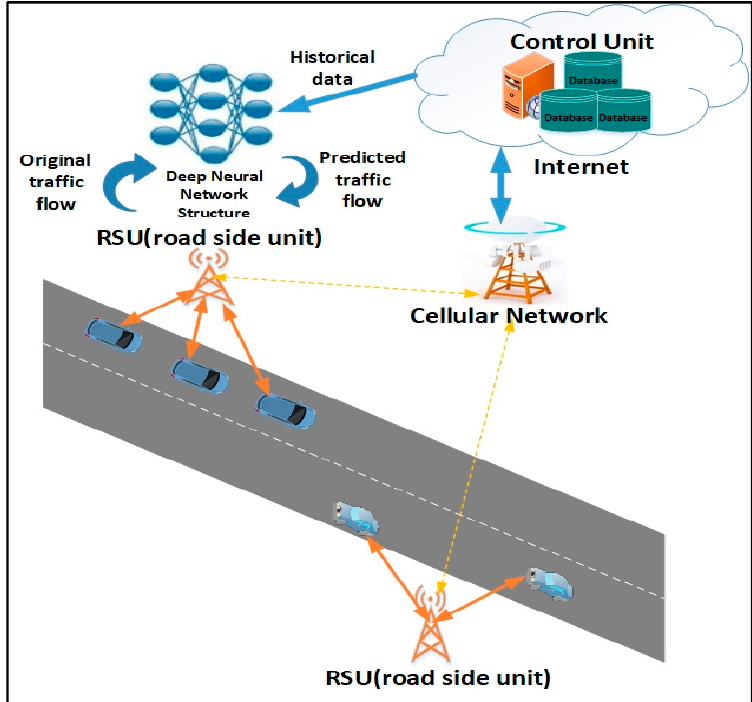
Figure 1. Delivery of content to vehicles via vehicle ‐ to ‐ roadside (v2r) links.